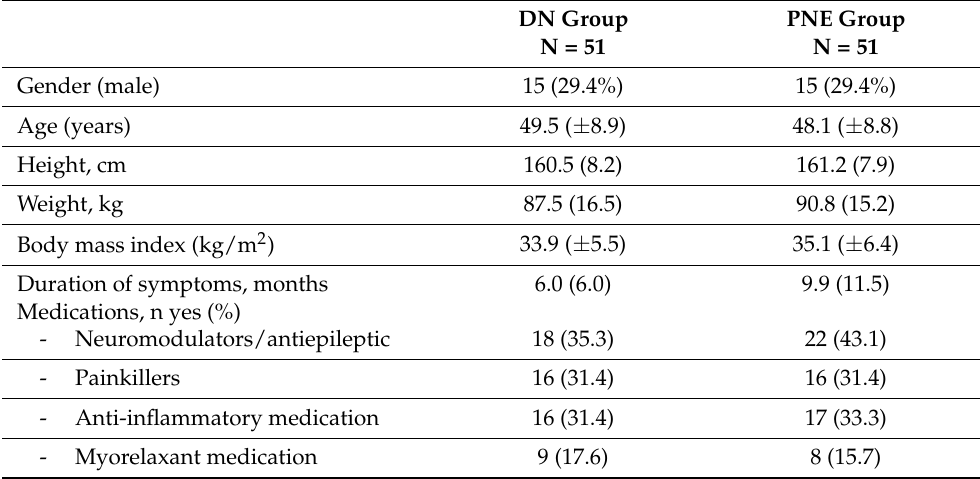
Table 1. Demographic characteristics of participants and other baseline characteristics.